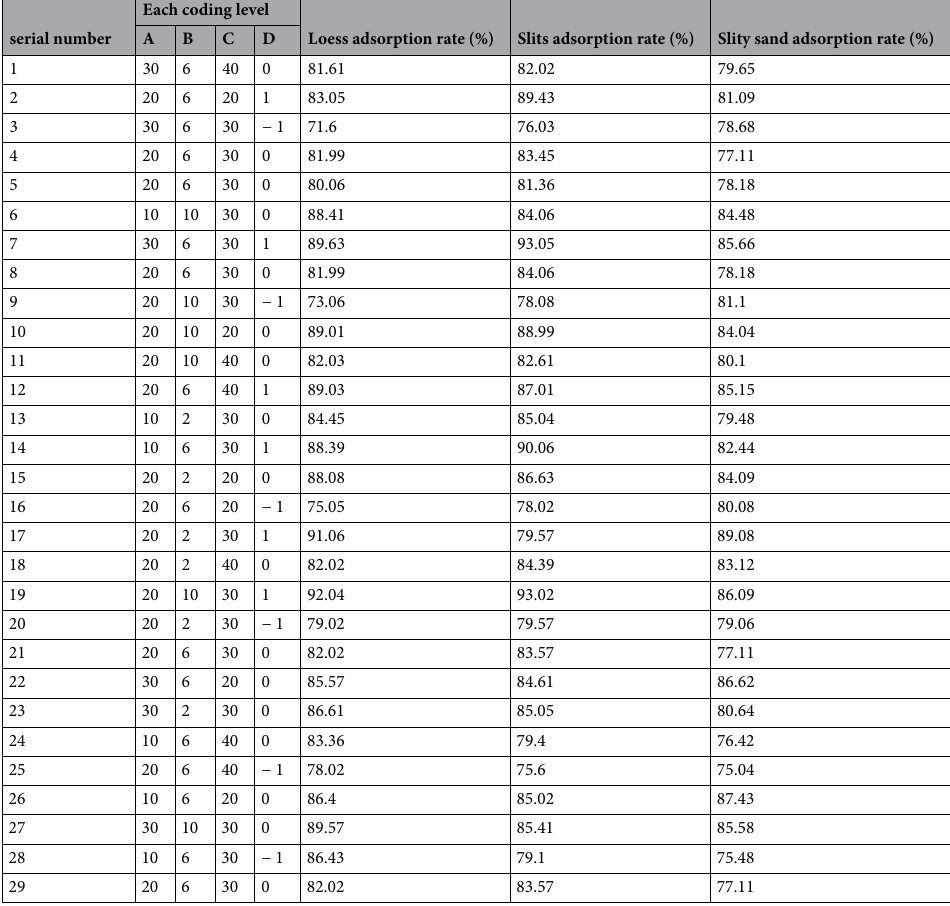
Table 6. Design and results of box Behnken experiment for three soils.